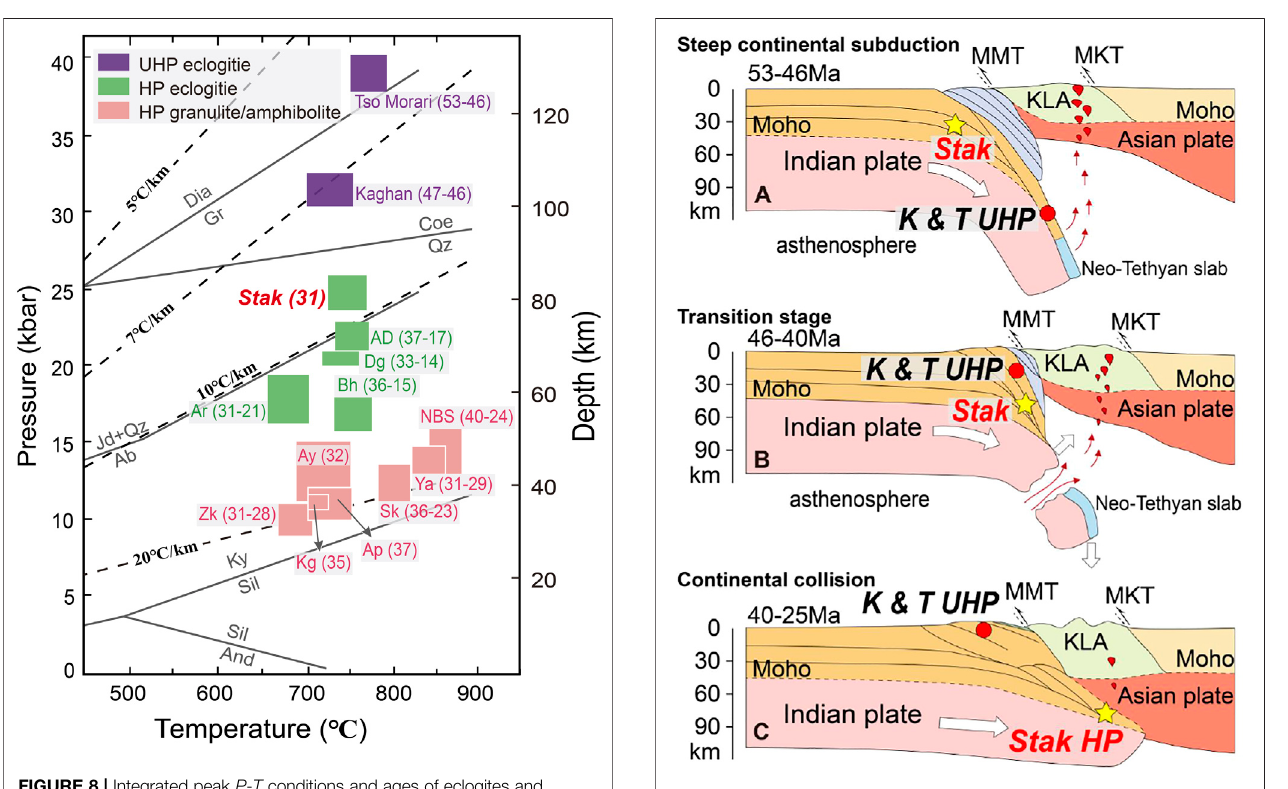
FIGURE 9 | Schematic diagrams illustrating the evolution process of the western Himalaya during the India – Asia collision. (A) Steep subduction and UHP metamorphism of the Indian continental slab at ca. 53 – 46 Ma. (B) Breakoff of the Neo-Tethyan lithosphere induced fast exhumation of UHP metamorphic rocks and then rebound of subducted Indian continental slab at ca. 46 – 40 Ma. (C) Continuous (ca. 40 – 25 Ma) low-angle underthrusting oftheIndian continentalslab duringcollisioncontributedtothe HP metamorphism and magmatic lull. K & T, Kaghan and Tso Morari; KLA, Kohistan – Ladakh